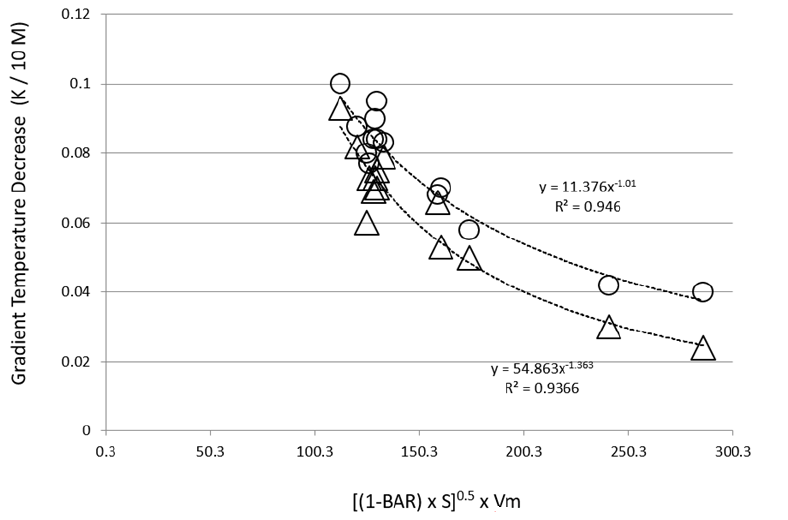
Figure 10. Cooling Efficiency of Mitigation Measures as a function of the Flow-Through Open Areas.